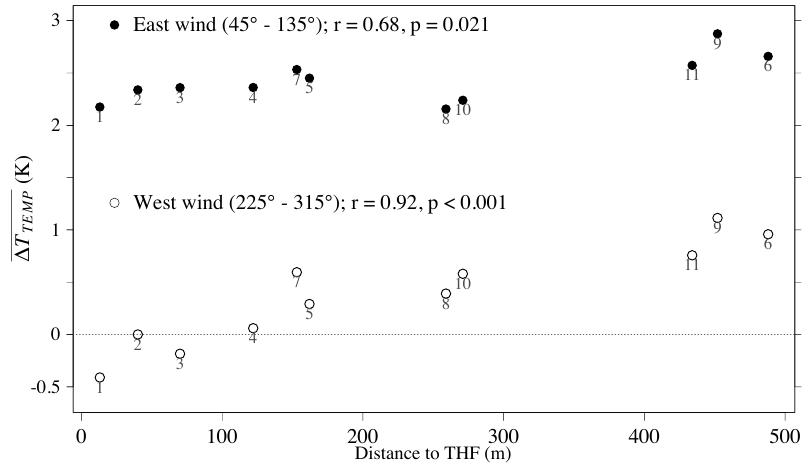
Figure 4. Mean night-time air temperature ( T ) difference at each measurement site within the Schillerkiez in relation to the distance of each site to the eastern border of the Tempelhofer Feld (THF), depicted as the difference of individual T to T measured at the DWD station on the THF ( ∆ T TEMP , 1.4 km west of the eastern THF border). Empty circles: conditions with light ( ≤ 3 m/s) west wind (28 June, 3, 4 July); filled circles: conditions with light east wind (23, 25, 29